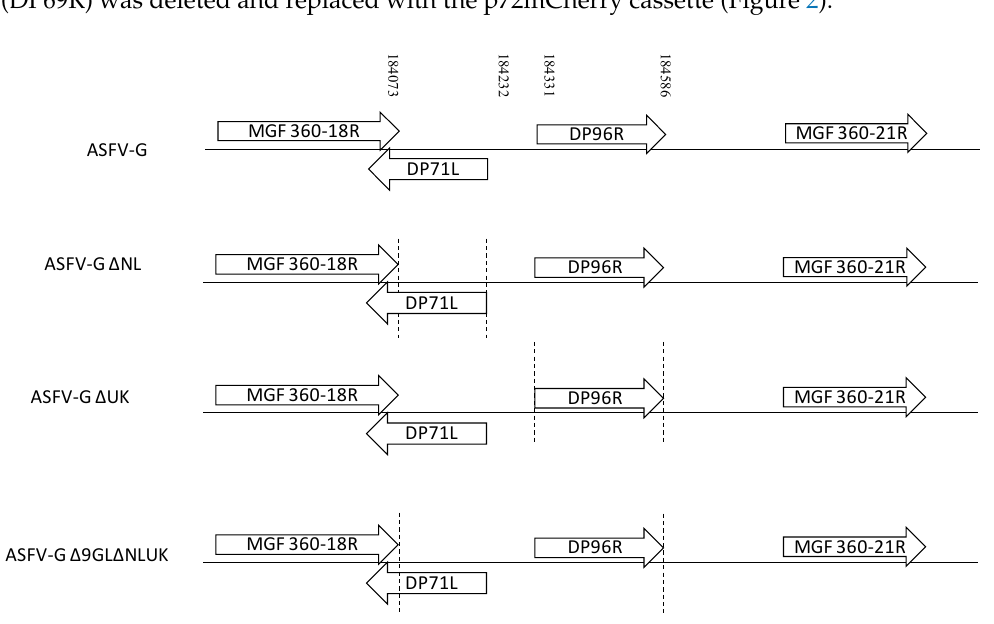
Figure 2. Schematic representation of the NL and UK gene regions deleted in recombinant viruses ASFV-G- Δ NL, ASFV-G- Δ UK, and ASFV-G- Δ 9GL/ Δ NL/ Δ UK. The indicated region between the dotted lines is replaced with a p72mCherry cassette. Nucleotide positions indicating the boundaries of the deletion relative to the ASFV-G genome are indicated.